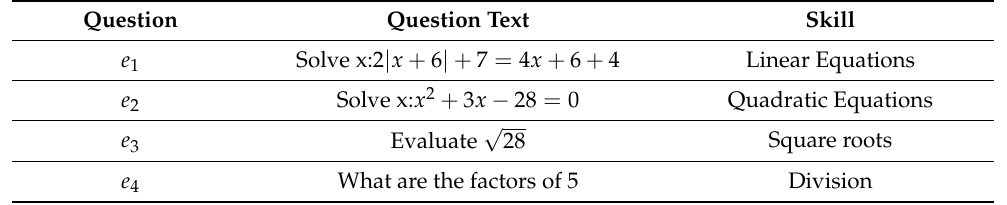
Table 5. Some of the questions in the data